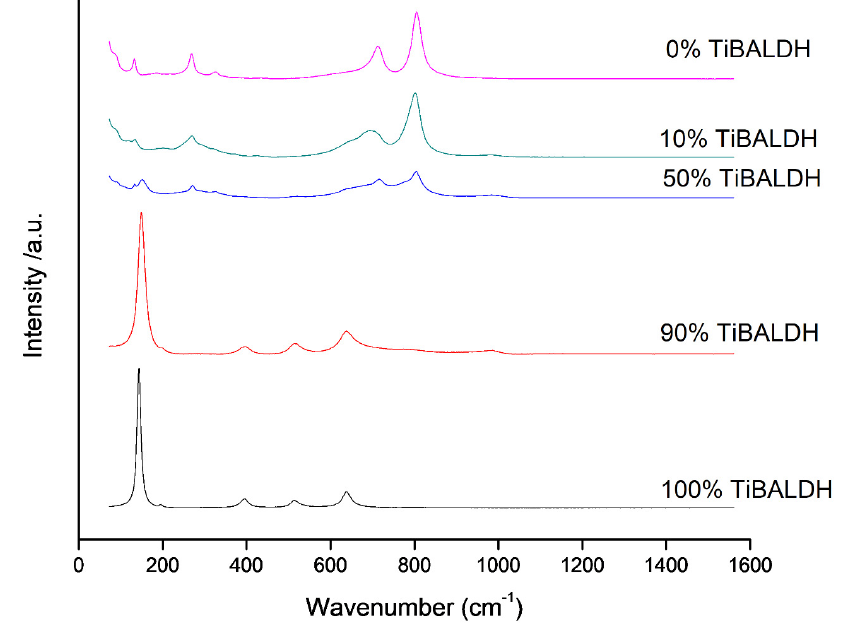
Figure 6. Raman spectra of annealed fibers.